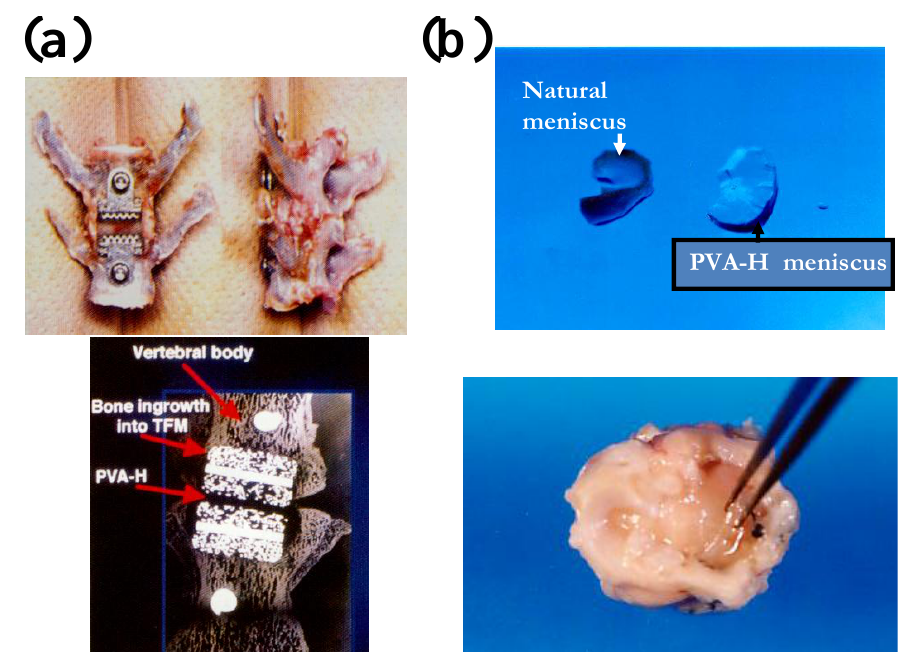
Figure 16. Other orthopedics implants using PVA-H. (a) Artificial intervertebral disc. (b) Artificial